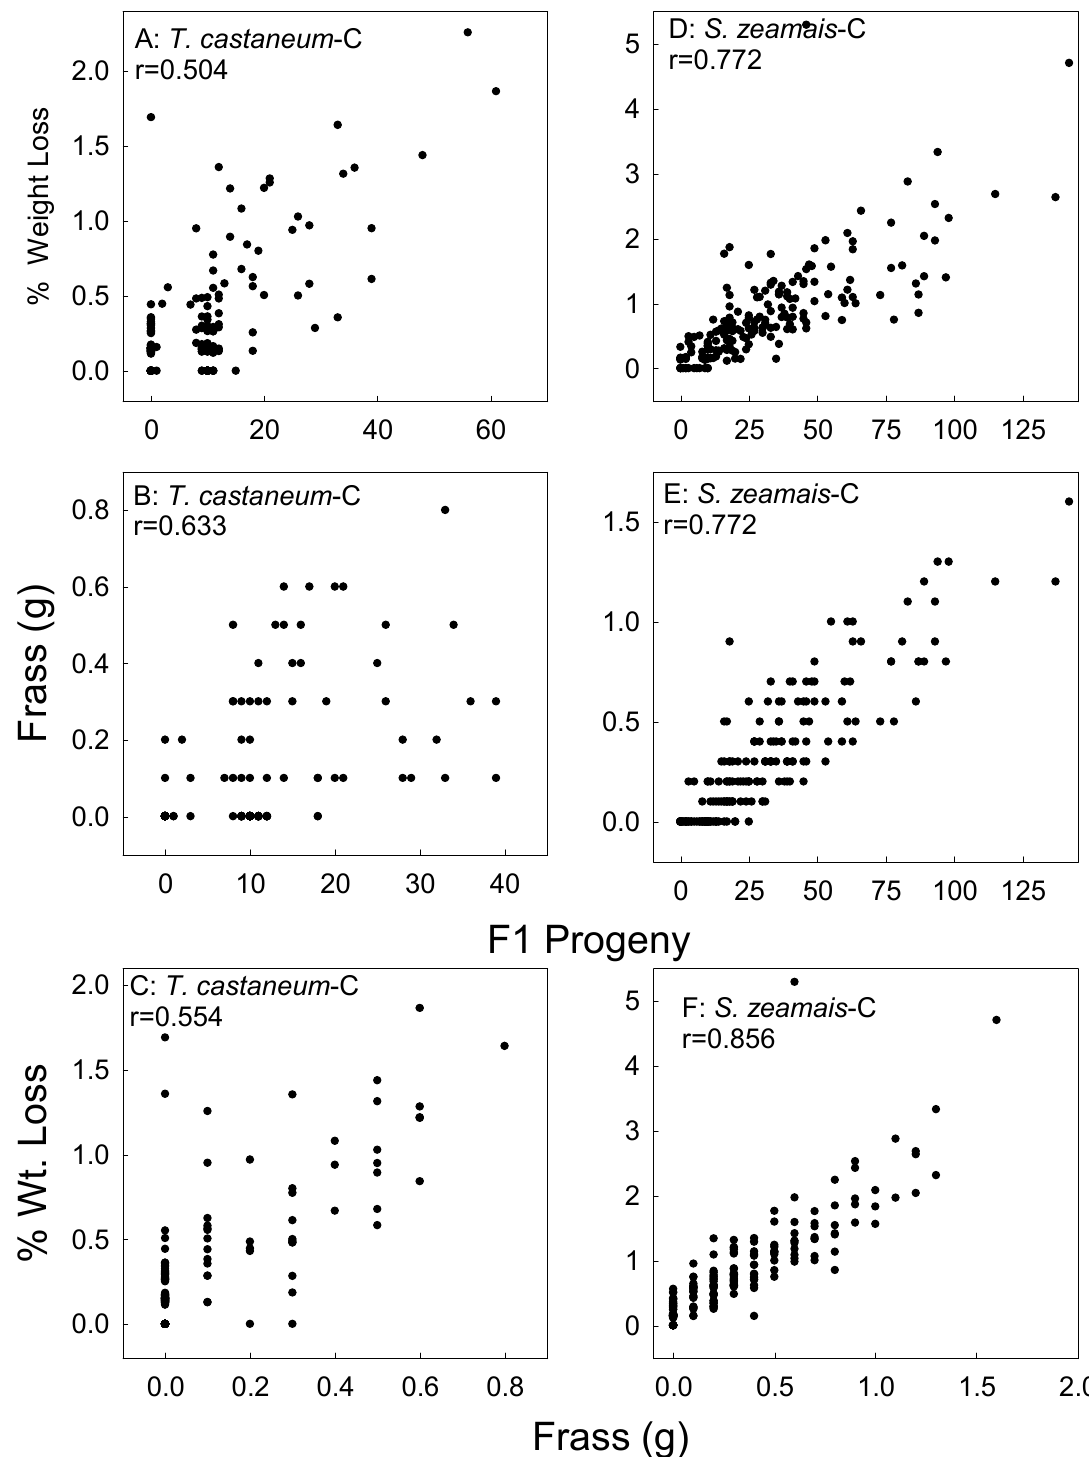
Figure 6. Correlation of corn ( C ) sample weight loss and frass weight with F 1 progeny of T. castaneum ( A , B ), sample weight loss with frass weight ( C ), sample weight loss and frass weight with F 1 progeny of S. zeamais ( D , E ), and sample weight loss with frass weight ( F ). Data for the two parental exposure regimes combined, data for all treatments and all bioassay months combined.